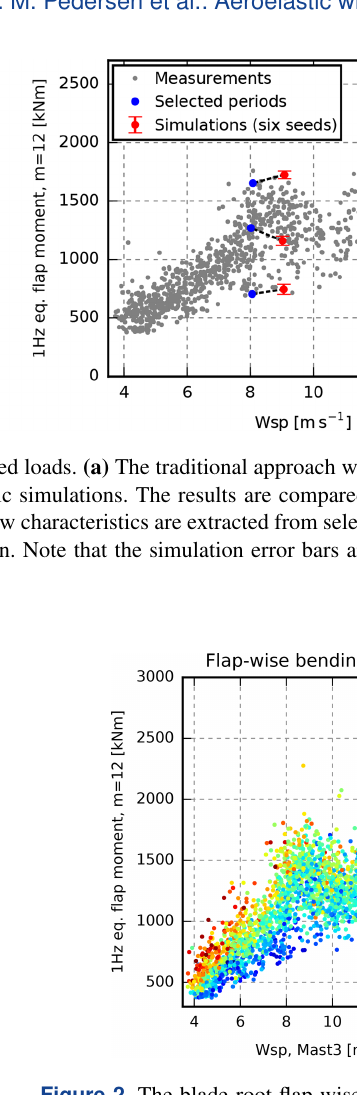
Figure 2. The blade-root flap-wise fatigue load plotted as a func- tion of wind speed (Wsp) and coloured by turbulence intensity. The turbulence intensity affects the blade-root fatigue loads. However, much of the scatter is caused by other